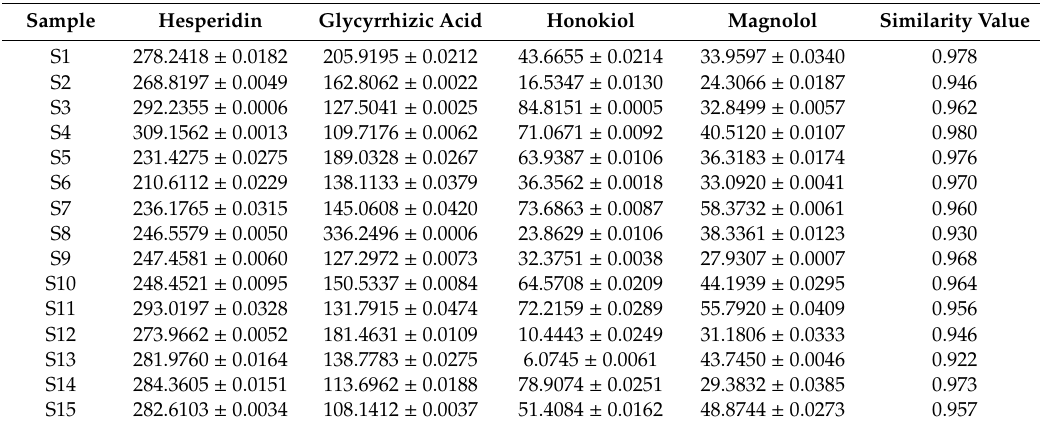
Table 3. The contents of four analytes and similarity values for 15 batches of HWDs ( µ g / mL, Mean ± SD, n =